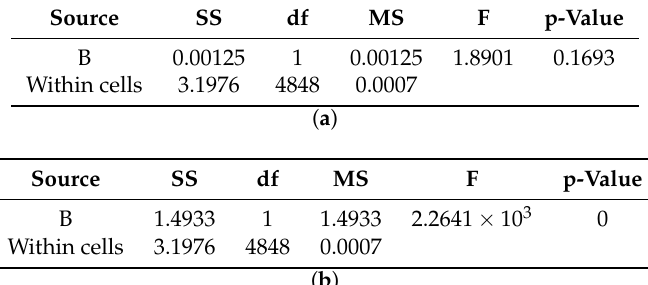
Figure A8. ANOVA tables for the analysis of the effect of factor B (amount of missing observations) on the expected accuracy. ( a ) One-way ANOVA for factor B given C = 1. ( b ) One-way ANOVA for factor B given C =